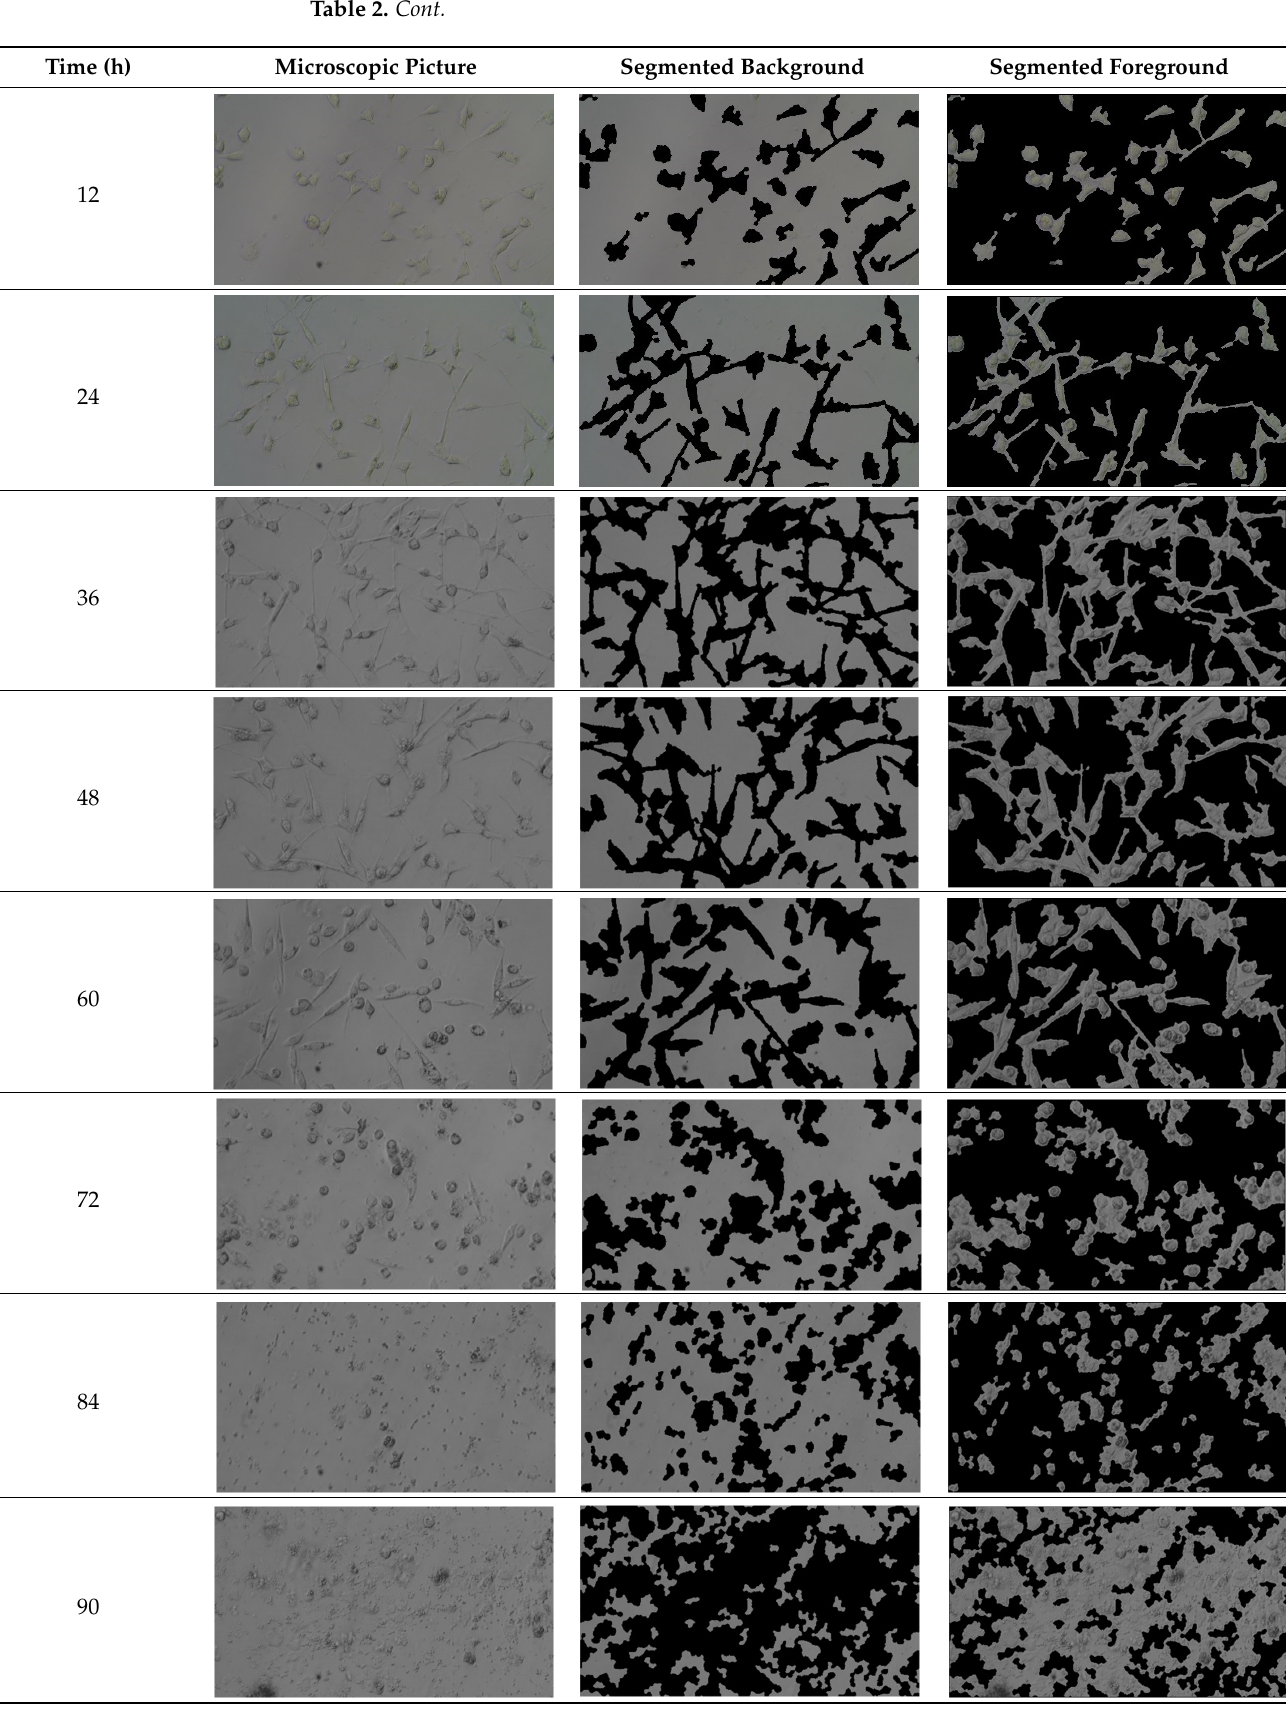
Table 2. Image processing procedures of cell detection: microscopic (left), segmented background (middle), and segmented foreground (right) images. The scale bar in the images is 0.1 mm, and the microscope magni fi cation was 10×. Time (h) Microscopic Picture Segmented Background Segmented Foreground 0